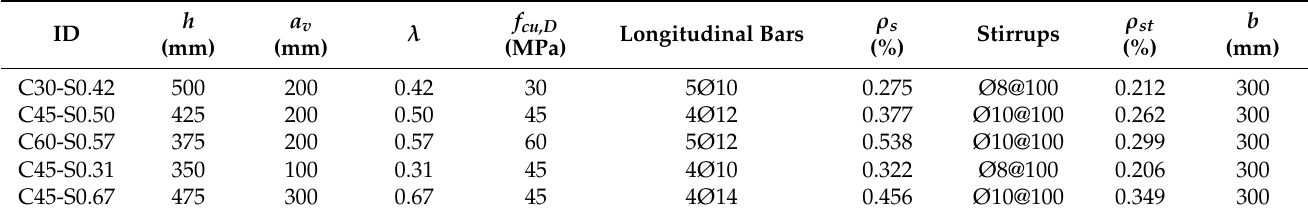
Table 1. Design parameters of corbels.